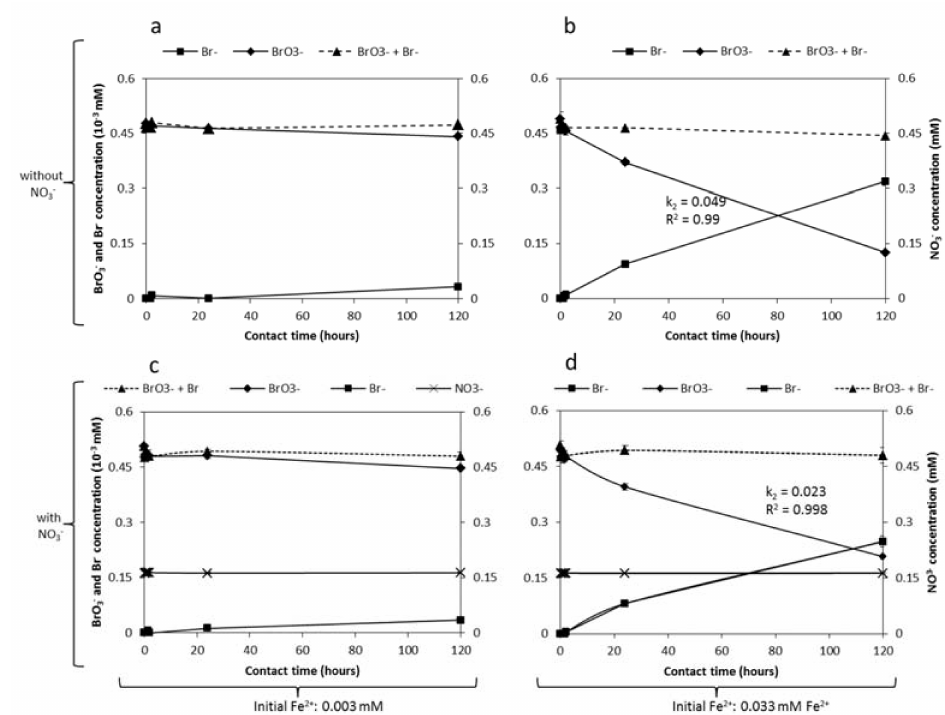
Figure 7. BrO 3 − reduction after dosing with ( a,c ) 0.003 mM or ( b,d ) 0.033 mM Fe 2+ , simulating MAR concentrations, in the ( a,b ) presence and ( c,d ) absence of NO 3 − . ( c,d ) Initial BrO 3 − and NO 3 − concentrations were 0.5 µ M and 0.16 mM, respectively. Initial pH was 7.0.